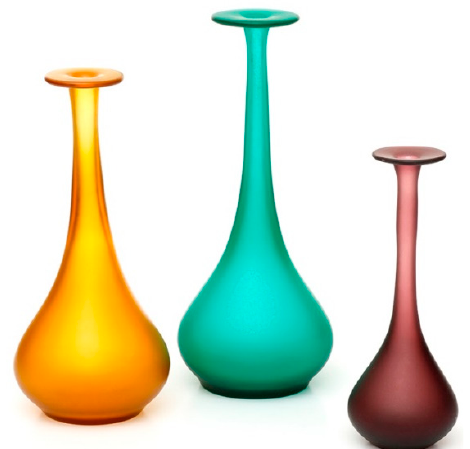
Figure 1. Burma , Carmo Valente, Fábrica Escola Irmãos Stephens (F.E.I.S), 1974. Photo credit: photographer Jorge Soares. Arquivo do Museu do Vidro—Câmara Municipal da Marinha Grande. Private collection of Pedro Moura Carvalho.